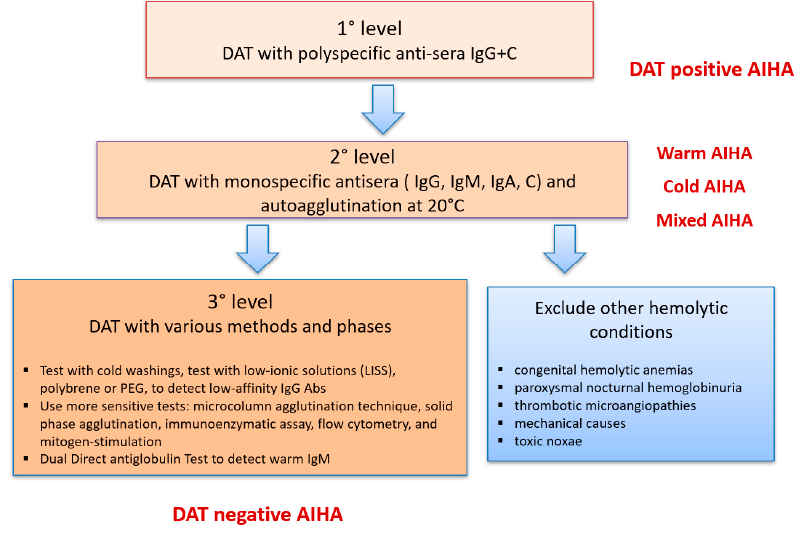
Figure 2. The various levels of direct antiglobulin test (DAT) study. The 1st level is DAT with polyspecific anti-sera that in the presence of hemolysis and anemia leads to the diagnosis of autoimmune hemolytic anemia (AIHA). The next and fundamental step (2nd level) is DAT with monospecific anti-sera and autoagglutination at 20 °C that allows the distinction of warm (positive for IgG+ or − C at low titer, autoagglutination negative), cold (positive for C and autoagglutination positive), and mixed forms (positive for IgG + C at high titer and autoagglutination positive). For negative cases, it is required to perform the DAT with various methods and phases (3rd level) and exclude all the other causes of hemolysis. Despite all the tests, up 5–10% of cases would remain DAT negative. Ig: immunoglobulins; PEG: polyethylene glycol; Abs: antibodies.